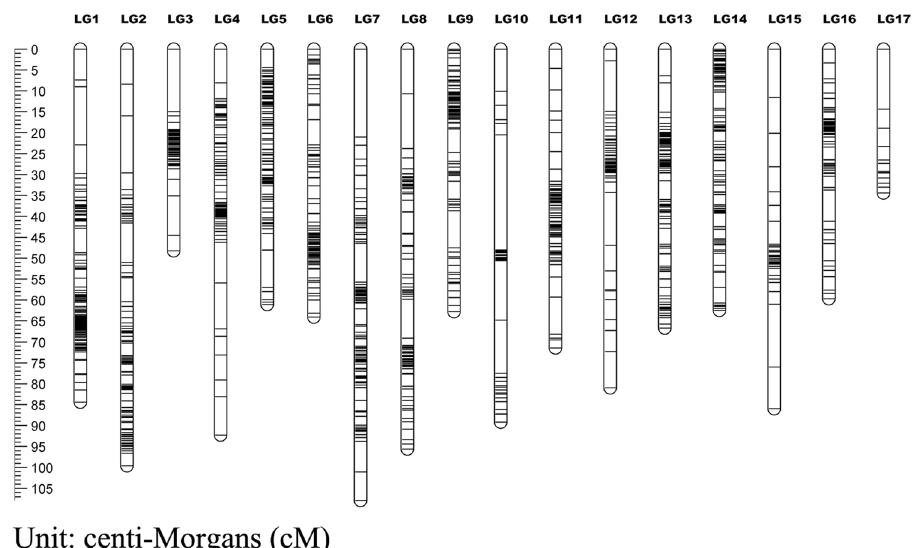
Figure 7. Genetic lengths and marker distribution in 17 linkage groups of seed parent linkage map. A black bar means a 2b-RAD marker. The left scale plate imeans genetic distance (centiMorgan as